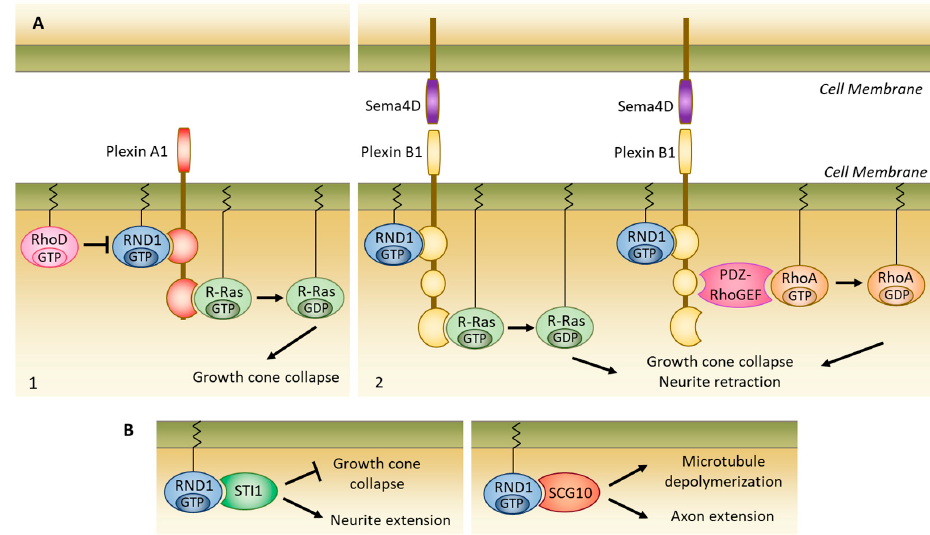
Figure 4. RND1 is involved in the formation of nerve connections. ( A ) Plexin dependent mechanisms. 1: The interaction of RND1 with plexin A1 stimulates its R-Ras GTPase activity, leading to the growth cone collapse. This effect occurs even in the absence of a semaphorin signal. This interaction can be inhibited by RhoD, which binds the plexin to the same binding site as RND1. 2: After stimulation by semaphorin 4D (Sema4D), the interaction of RND1 with plexin B1 stimulates its R-Ras GTPase activity and its binding with PDZ-RhoGEF, resulting in the inhibition of R-Ras and the activation of RhoA, respectively. These mechanisms both contribute to growth cone collapse and neurite retraction. ( B ) Plexin independent mechanisms. The interaction of RND1 with STI1 inhibits growth cone collapse inhibition induced by the RND1-Plexin A1 association and increases neurite extension. Binding of RND1 with SCG10 induces microtubule depolymerization and axon extension.